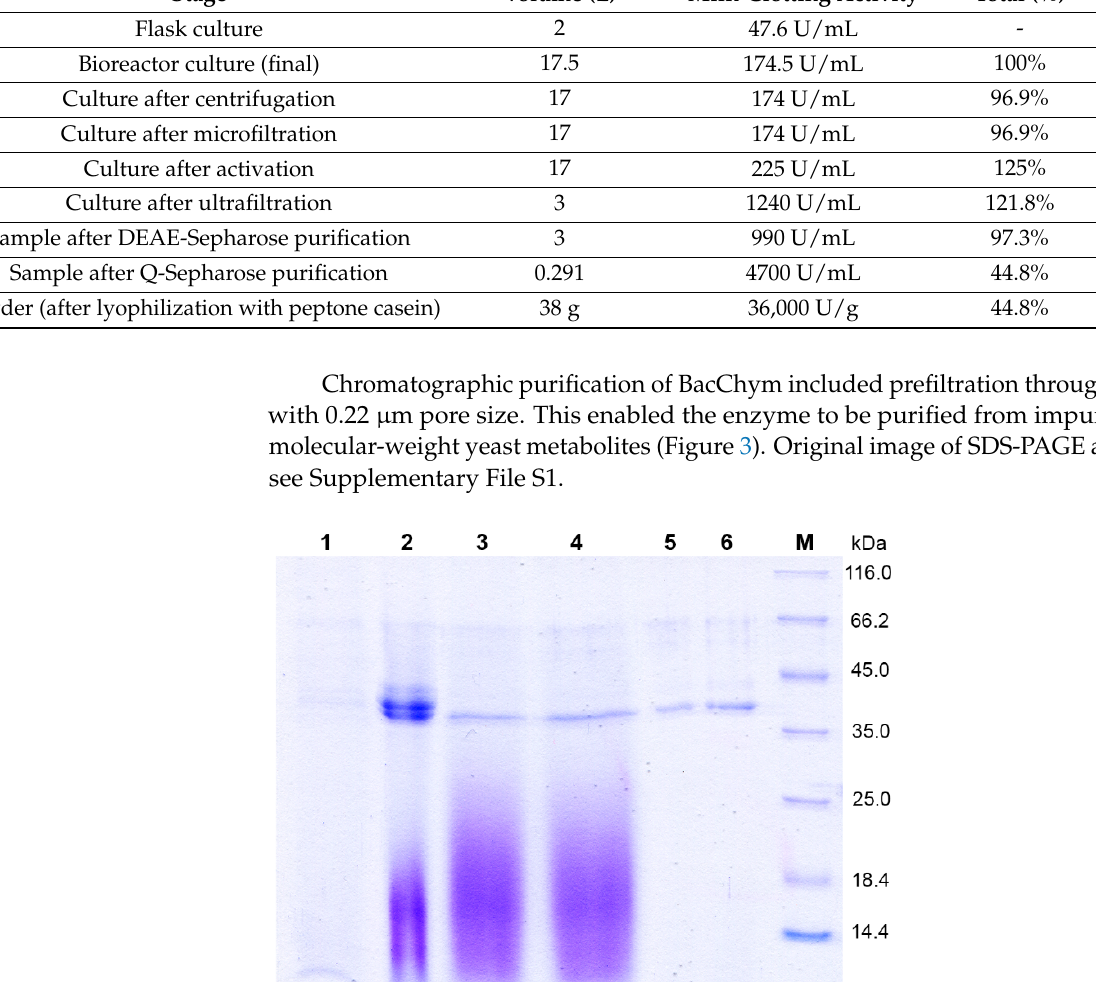
Figure 3. Chromatographic purification of the BacChym. Lane 1, cultural medium after 120 h; Lane 2, the sample after ultrafiltration through the 10 kDa membrane; Lanes 3 and 4, SP-Sepharose-purified fractions; Lanes 5 and 6, Q-Sepharose-purified fractions; M, molecular-weight markers. The milk-clotting activity of purified BacChym and BovChym was tested on reconsti- tuted cow’s, goat’s, ewes’, camel’s and mare’s milk; the results are presented in Table 2. Table 2. The milk-clotting activity of purified BacChym and BovChym tested on reconstituted cow’s, goat’s, ewes’, camel’s and mare’s